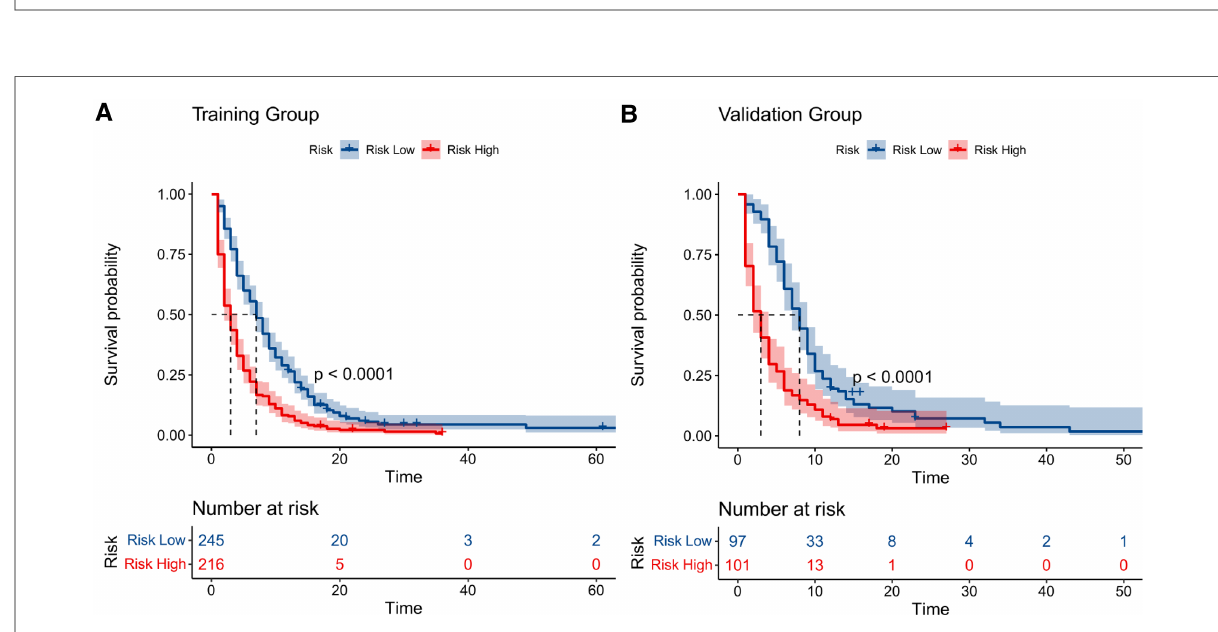
FIGURE 9 DCA curves of the prognostic model at 3 ( A ), 6 ( B ), and 12 months ( C ) in the training group, and at 3 ( D ), 6 ( E ), and 12 months ( F ) in the validation